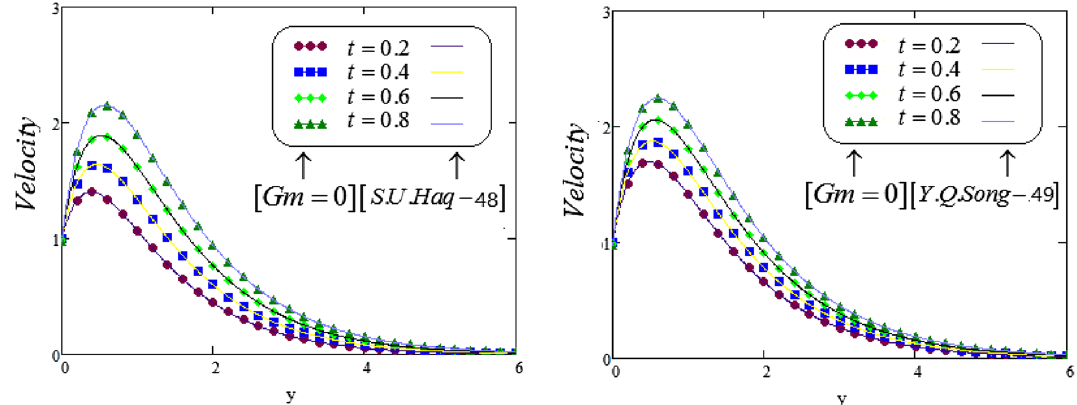
Figure 18. Comparison of the present velocity graphs, taking Gm = 0, with S. U. Haq and Y. Q. Song velocity